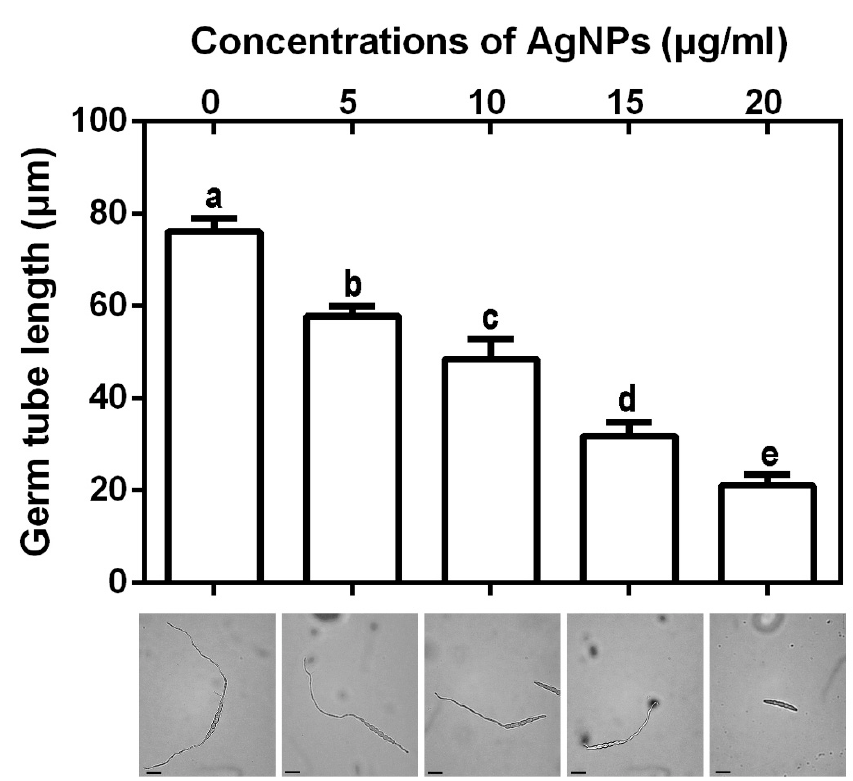
Figure 6. Effect of the synthesized AgNPs at four different concentrations on germ tube growth. The biosynthesized AgNPs were able to inhibit germ tube growth of F. graminearum strain PH − 1. Data are a mean value ± standard error of three replicates, and bars with the same letters are significantly different in LSD test ( p < 0.05).